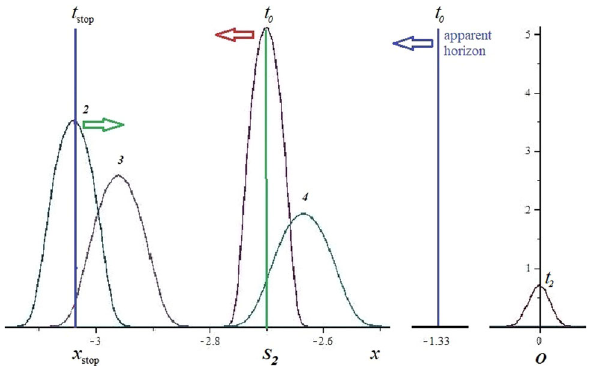
Fig. 3 The consecutive profiles in a logarithmic scale of the intensity of the fermion emitted by the source S 2 which starts in the backward direction turning back in x stop to the observer O where this arrives at the instant t 2 . The decay and dispersion are present during the entire propagation